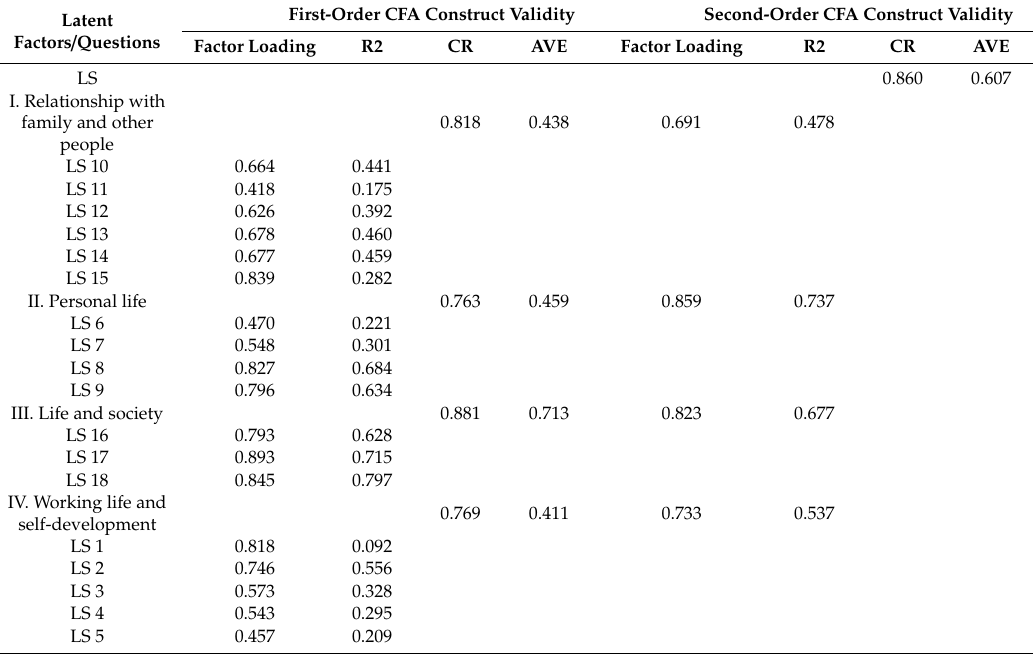
Table 3. Construct validity of first and second order CFA results.